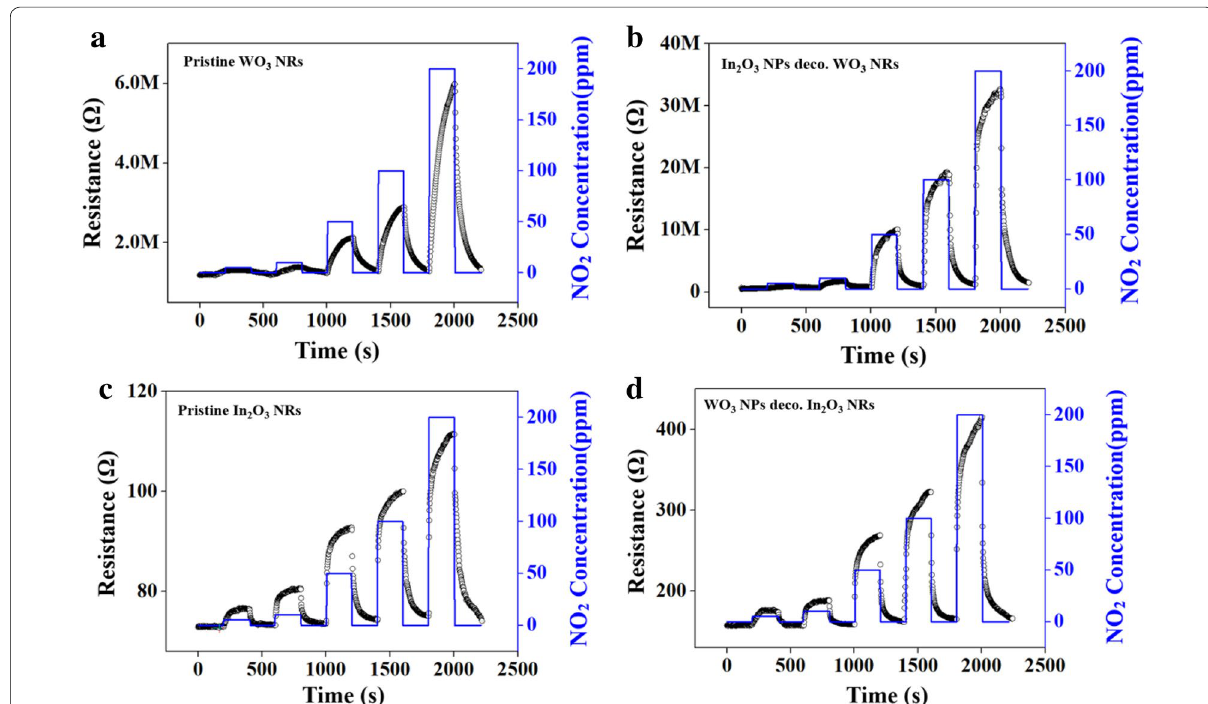
Fig. 5 Dynamic response curves: a pristine WO 3 NRs to NO 2 , b In 2 O 3 NPs‑decorated WO 3 NRs to NO 2 , c pristine In 2 O 3 NRs to NO 2 , and d WO 3 NPs‑decorated In